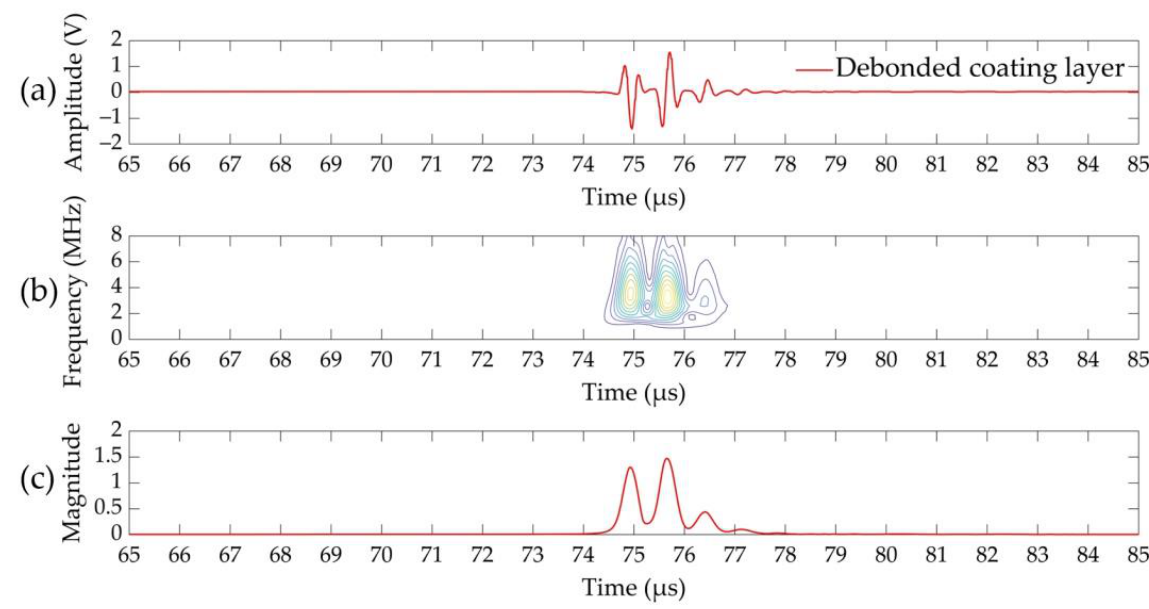
Figure 5. Pulse echo waveform from the debonded coating layer: ( a ) time domain waveform, ( b ) CWT of the waveform, and ( c ) the projection of the CWT magnitude to the time domain. Table 2. Waveform parameters from bonded and debonded